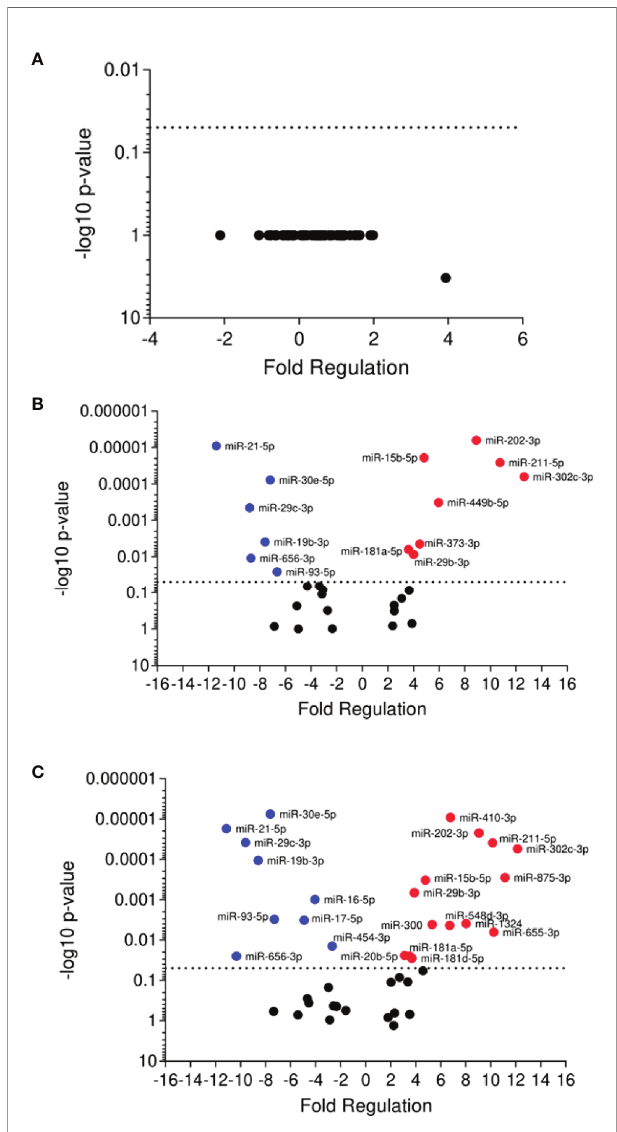
FIGURE 3 | Volcano plot of differential expression of miRNA in plasma of cutaneous leishmaniasis patients. Volcano plot of differential expression of miRNA in plasma samples of active disease patients (A) and self-healed (B) compared to healthy individuals, and self-healed (C) compared to active disease patients. Each dot represents one miRNA. Red dots indicate the up- regulated miRNAs, and the blue dots represent the down-regulated miRNAs (P < 0.05). Black dotted line corresponds to p=0.05, log 10. The relative up- and down-regulation of miRNAs, expressed as boundaries of 2 or -2 of Fold Regulation, respectively. P-value was determined based on two-tailed Student ’ s t test. P < 0.05 (Student t test and Bonferroni